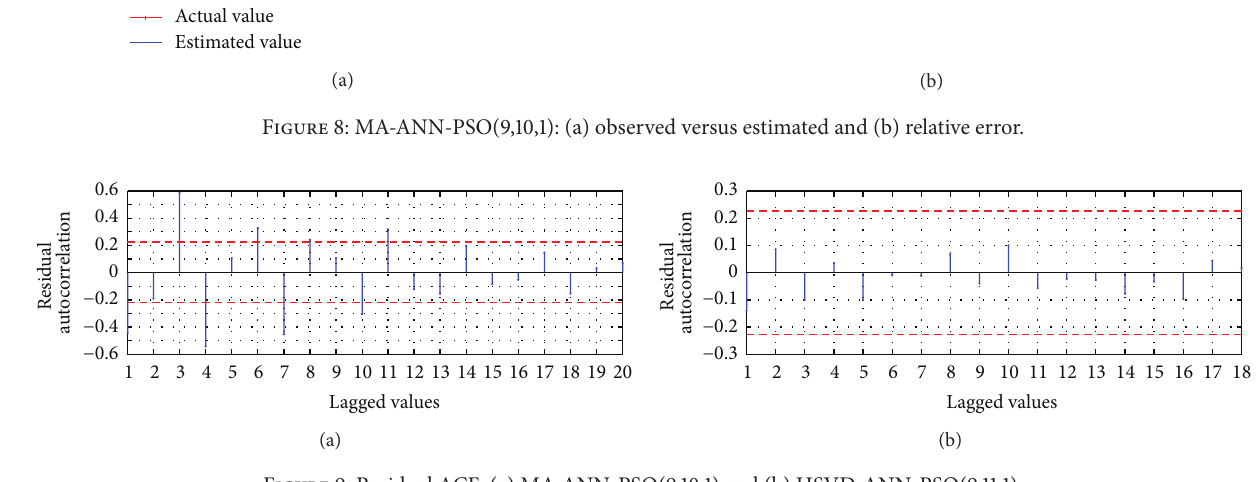
Figure 9: Residual ACF: (a) MA-ANN-PSO(9,10,1) and (b) HSVD-ANN-PSO(9,11,1).